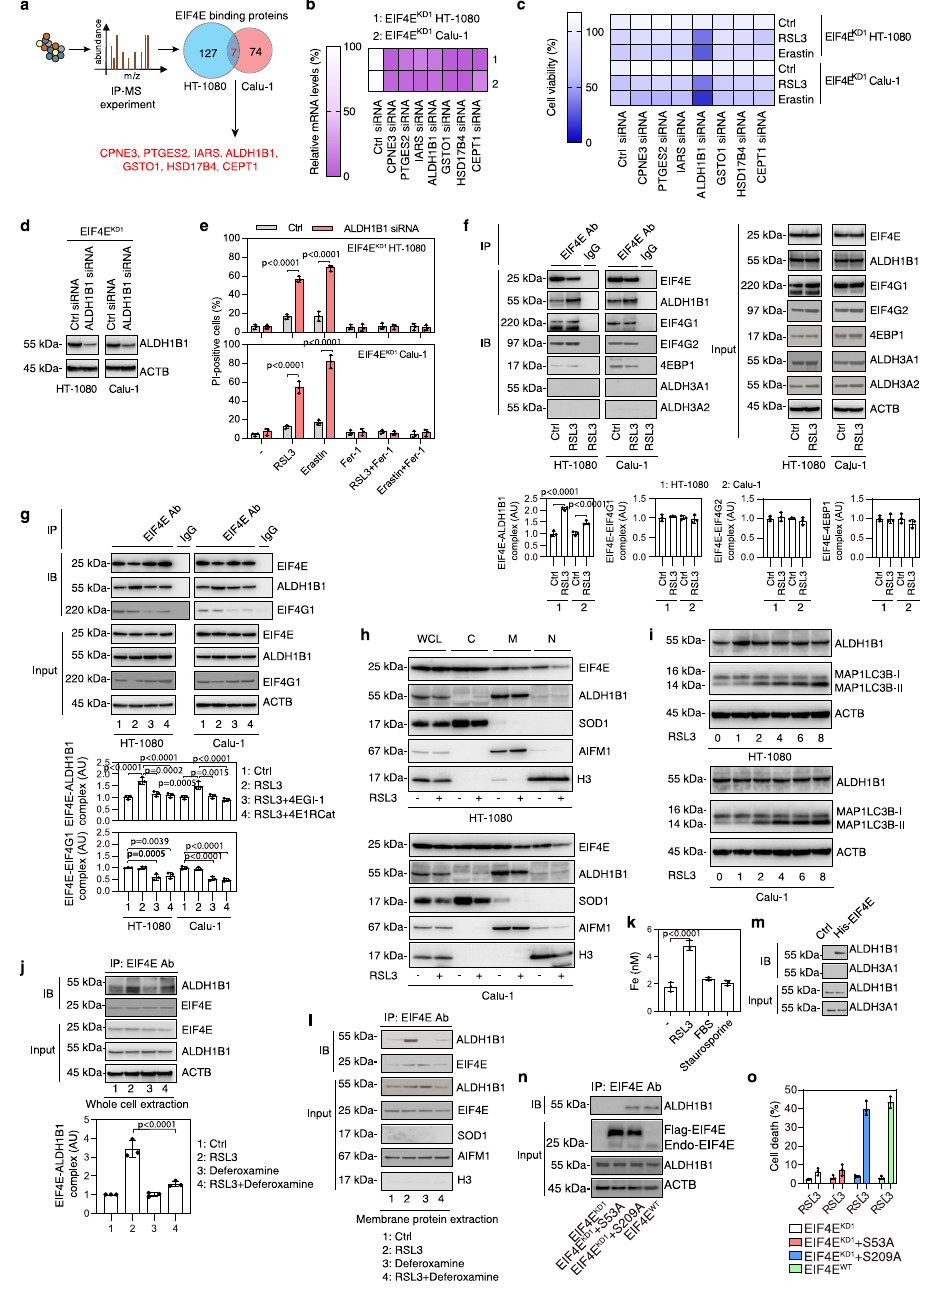
Fig. 3 | The EIF4E-ALDH1B1 complex facilities ferroptosis. a HT-1080 and Calu-1 cells were treated with RSL3 (0.5 μ M, 4h). EIF4E was immunoprecipitated using an anti-EIF4E antibody and subjected to mass spectrometry analysis. b Analysis of indicated mRNA in the corresponding siRNA knockdown EIF4E KD HT-1080 and EIF4E KD Calu-1cells( n =3). c CellviabilityofindicatedcellstreatedwithRSL3(0.5 μ M) or erastin (5 μ M) for 24h ( n =3). d Western blot analysis of protein expression in indicated cells. e Cell death analysis of indicated cells treated with RSL3 (0.5 μ M), erastin (5 μ M), or ferrostatin-1 (Fer-1; 1 μ M) for 24h. Mean±SD, n =3; two-way ANOVA with Tukey ’ s multiple comparisons test. f , g Immunoprecipitation (IP) ana- lysis of EIF4E-binding proteins in indicated cells treated with RSL3 (0.5 μ M), 4EGI-1 (10 μ M), or 4E1RCat (10 μ M) for 4h. Mean±SD, n =3; one-way ANOVA with Tukey ’ s multiple comparisons test. IB immunoblot. h Western blot analysis of whole-cell lysates (WCL) or cell fractionation (C: cytoplasmic; M: membrane/organelle;